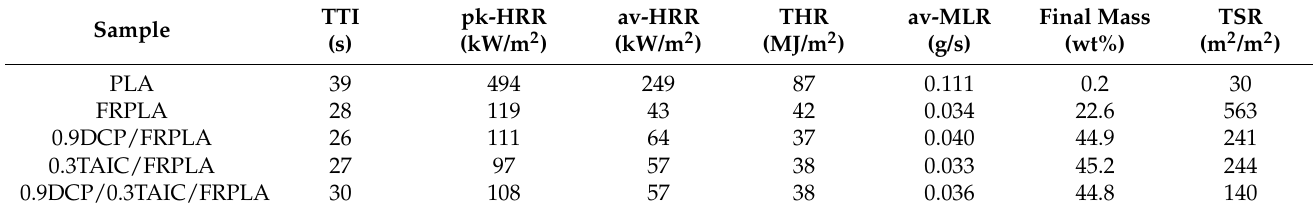
Table 2. Combustion parameters of pure PLA and PLA composites during cone calorimeter